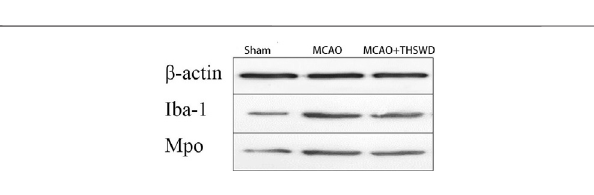
FIGURE 5 | β -actin is an internal reference. The blacker the band, the higher the protein expression level.